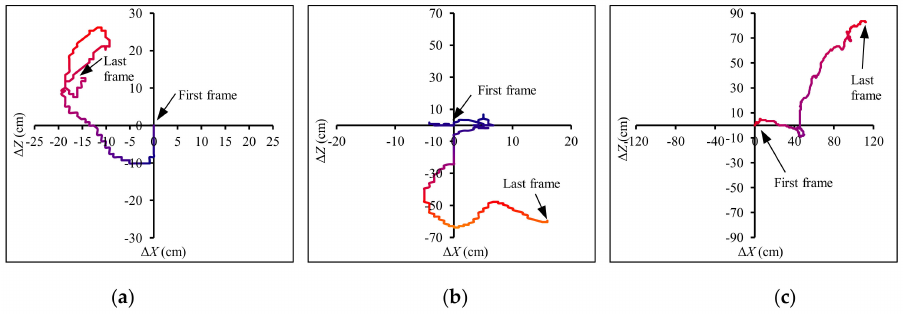
Figure 9. UAV drift trajectory. ( a ) Q = 341 m 3 /s; ( b ) Q = 643 m 3 /s; and, ( c ) Q = 1249 m 3